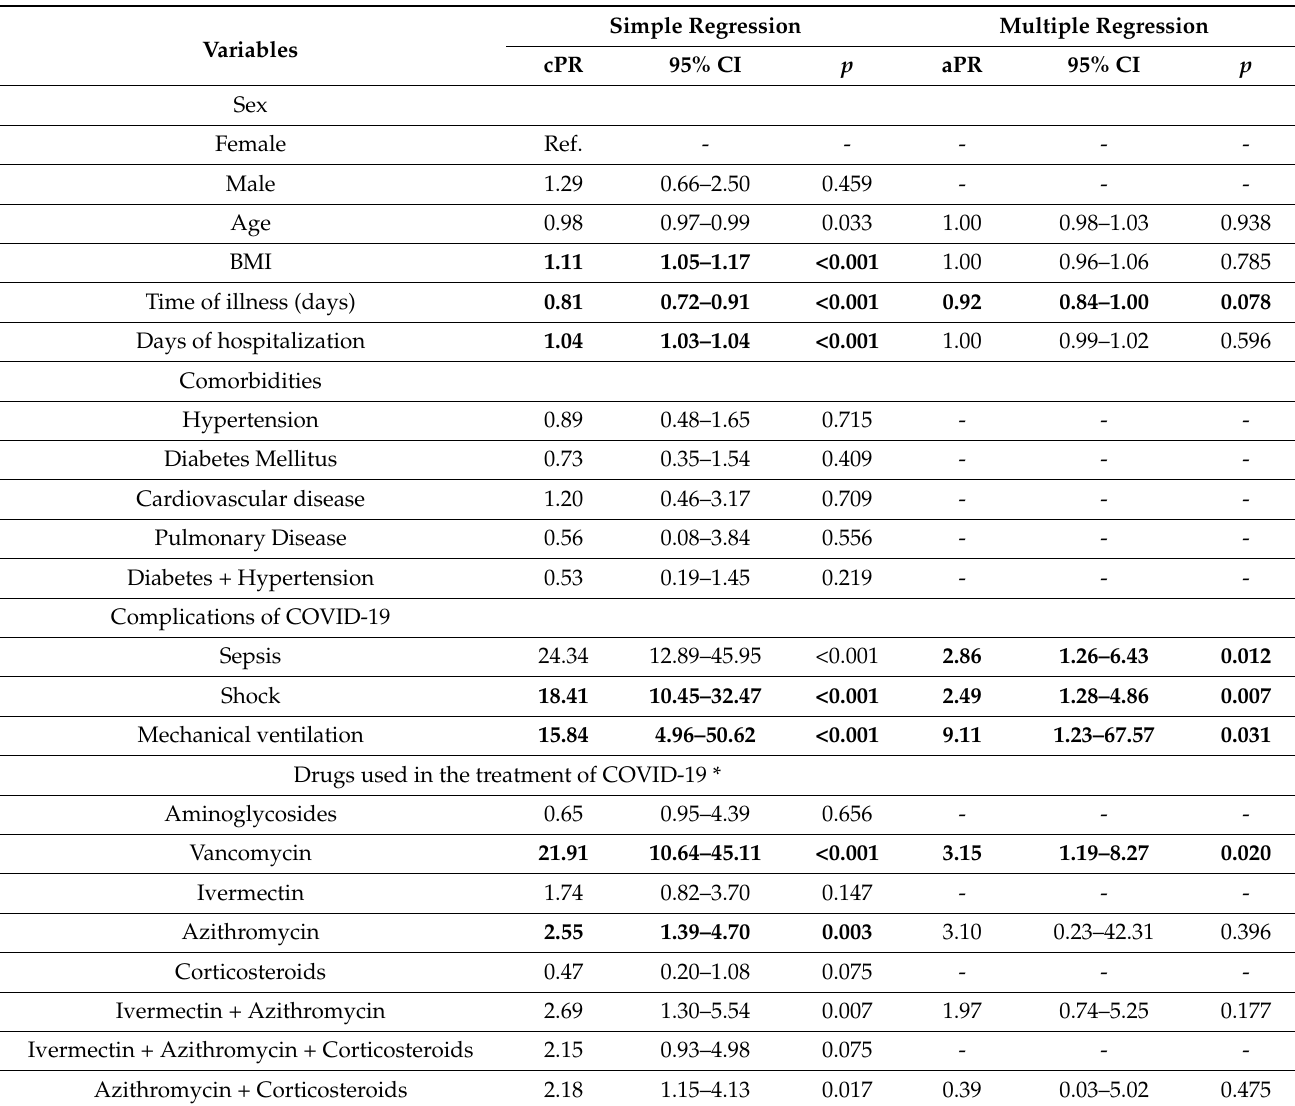
Table 3. Factors associated with AKI and antibiotic use in patients infected with SARS-CoV-2 treated at Hospital EsSalud II Ucayali, simple and multiple regression